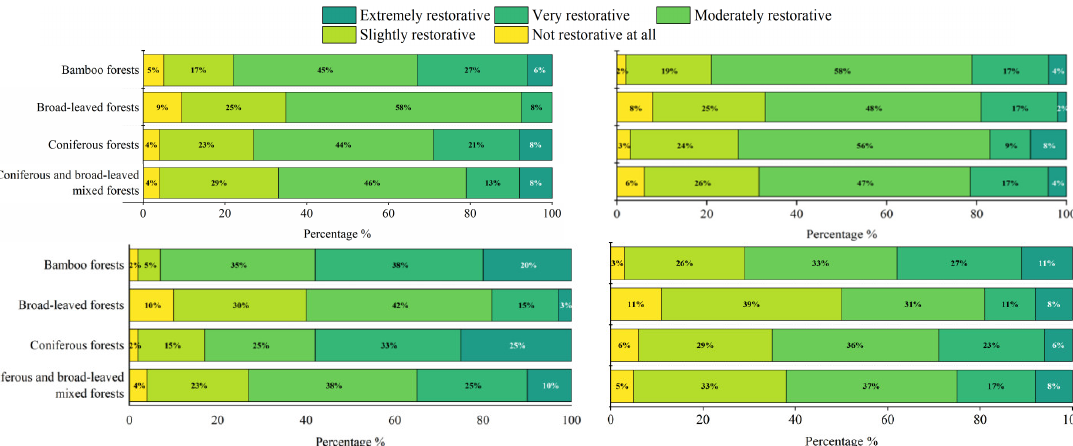
Figure 4. Proportion of ΔEMG ( top left ), ΔEDA ( top right ), ΔPPG ( bottom left ), and ΔRESP ( bottom right ) in different forests Scheme 4. Our results showed that ‘slightly restorative’ and ‘not restorative at all’ accounted for more than 40% of responses in broad-leaved forests. In bamboo forests, we found that only 7% of participants answered ‘slightly restorative’ and ‘not restorative at all’ for ∆ PPG, which suggested a consistency of above results for the decline of physiological indicators. Furthermore, our findings showed the restorative effect of RESP was limited in urban forests, with an average that was more than 38%.